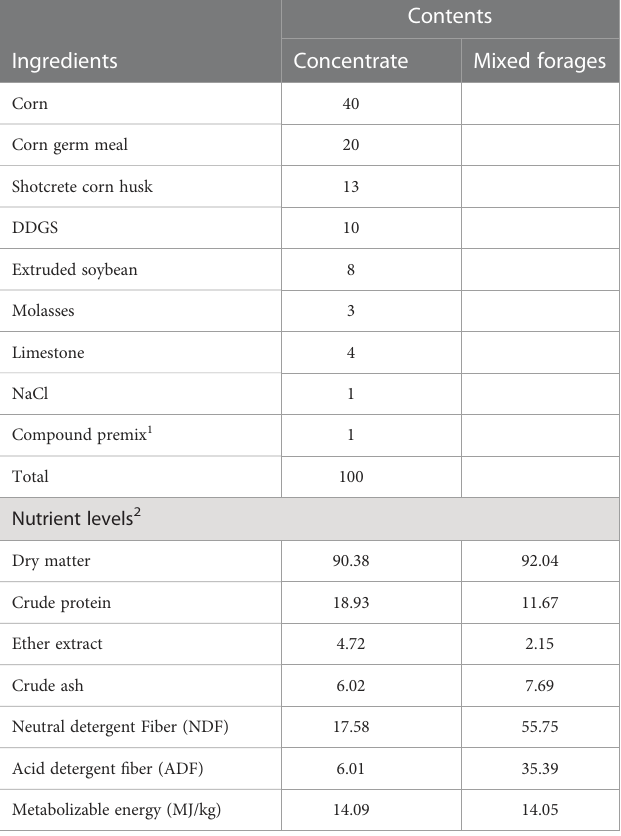
TABLE 1 Composition and nutrient levels of diets (DM basis,